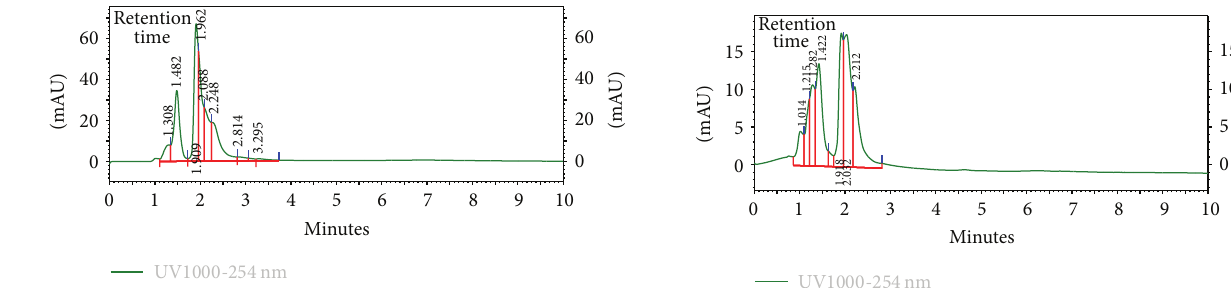
Figure 4: HPLC chromatogram (finger-printing) of methanol root extract (SHR) of S. hispidus at 𝜆 254